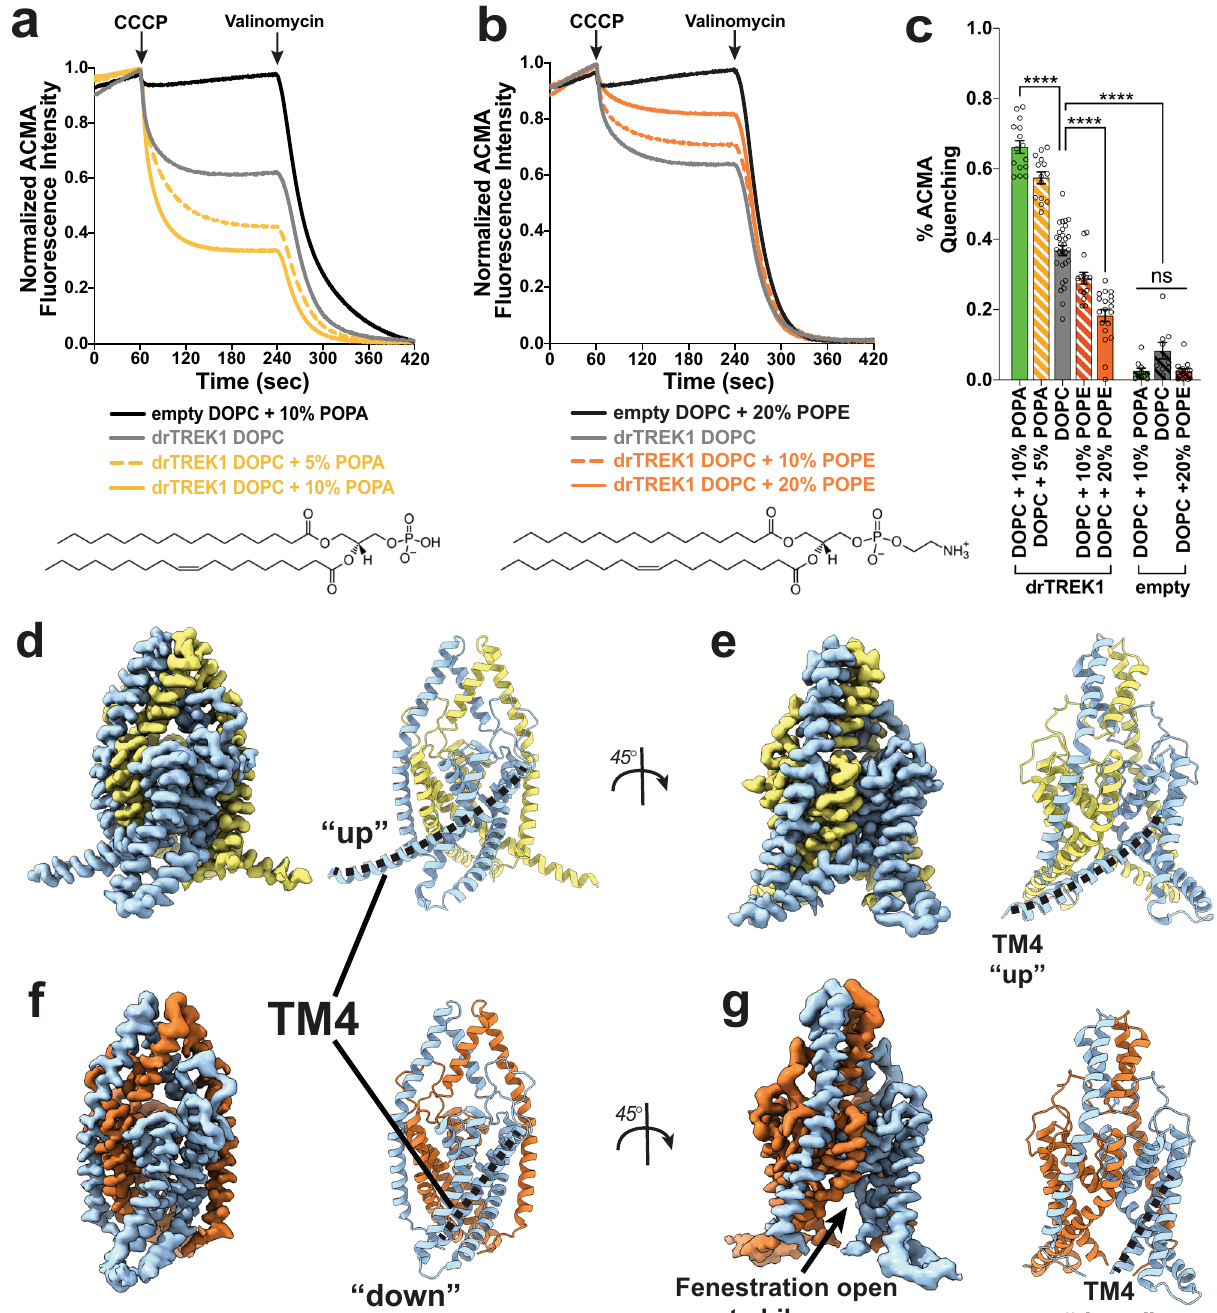
Fig. 2 | Functional and structural effects of phospholipids on the TREK1 channel. ACMA fl uorescence quenching assays to study the function of puri fi ed TREK1 protein in varied lipid compositions ( a – c ). Quenching was initiated by the addition of the proton ionophore CCCP and allowed to proceed to completion by the addition of the potassium ionophore valinomycin. Signals were normalized to the fi nal baseline value prior to the addition of CCCP (time t =59s) and the fi nal fl uorescencevalue inthe tracings(time t =420s).Averagedcompositetracesof all quenching reaction measurements are shown in ( a ) and ( b ), with liposome com- positions indicated. TREK1-dependent ACMA quenching was measured as (1 - Normalized ACMA fl uorescence intensity at time t =239s) and is shown in ( c ).